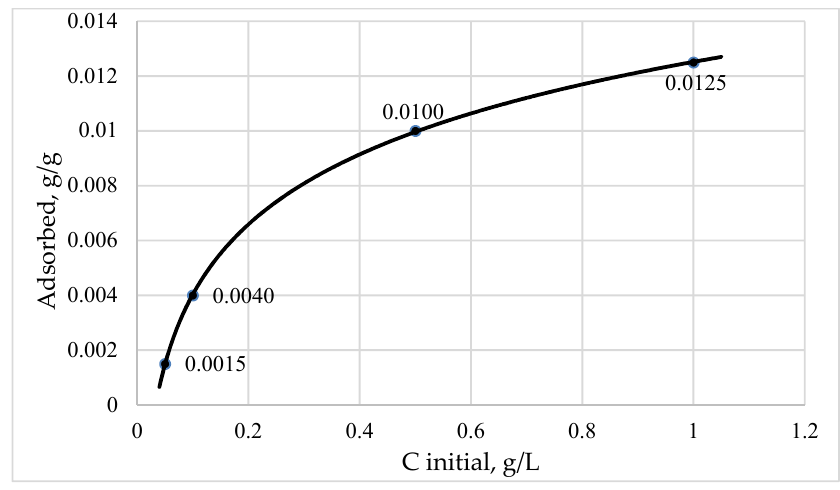
Figure 2. Isotherm of FA adsorption on kaolinite.